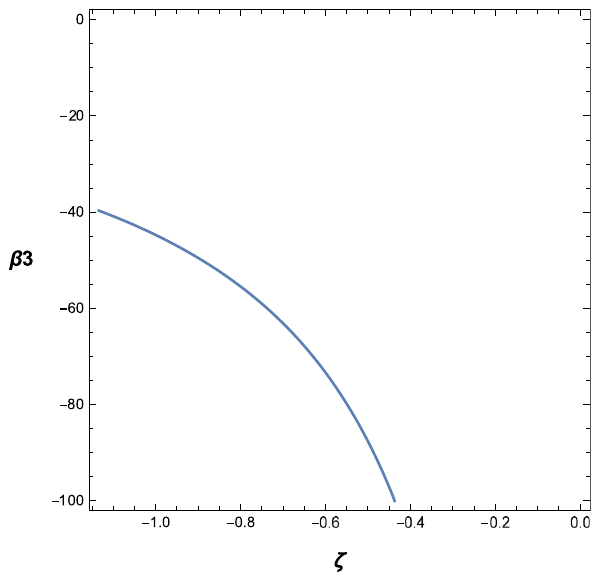
Fig. 6 The relationship between β 3 and ζ for d = − 0 . 24 when E 3 is fixed ( the maximal value ) under timelike condition. It reflects that E 2 = 1 can be satisfied in this